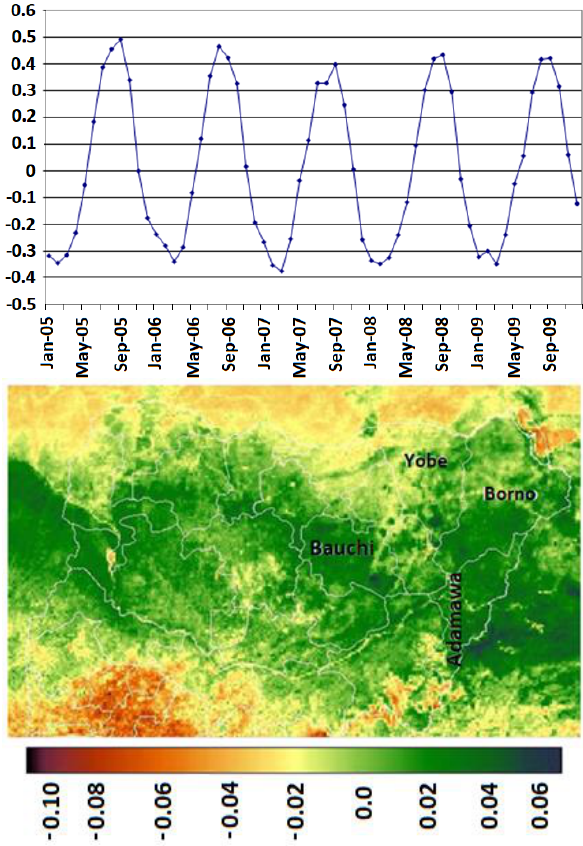
Figure 4. Component 2 image and its corresponding graph of loadings